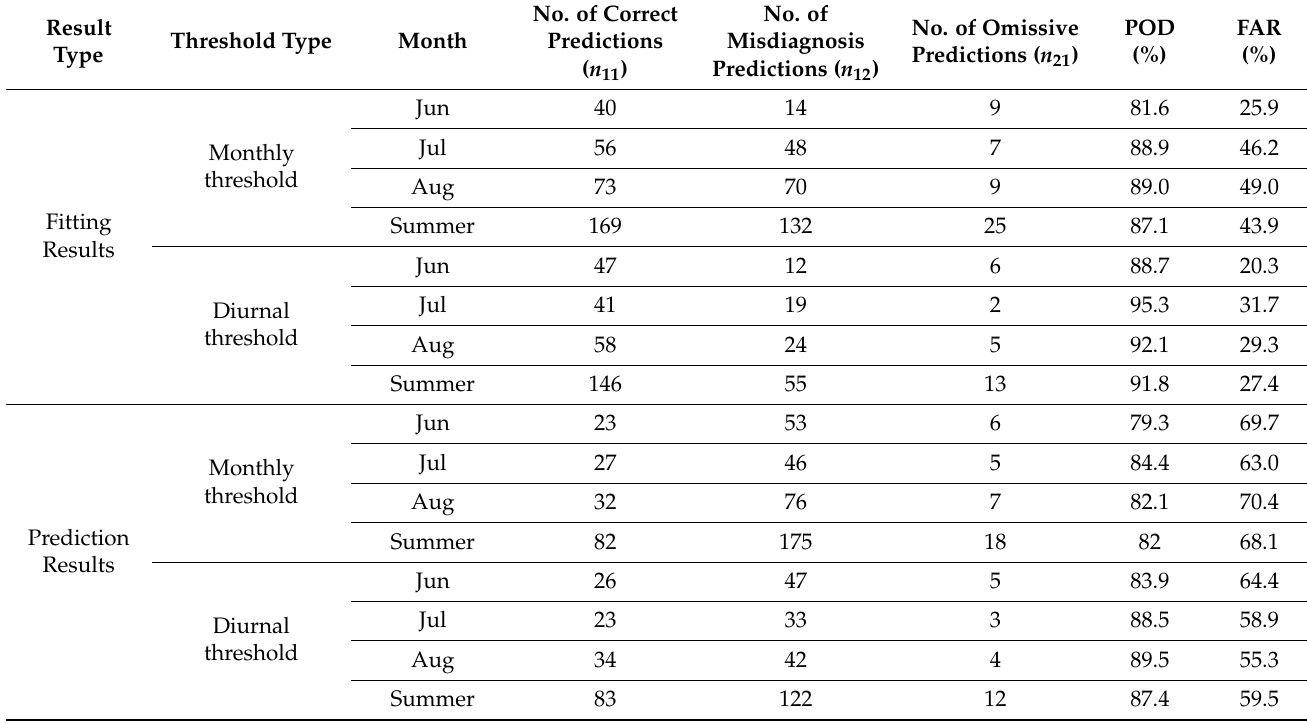
Table 1. Comparison of the fitting (2010–2017) and prediction (2018–2019) results for the summer season applying the diurnal and monthly thresholds for the PWV